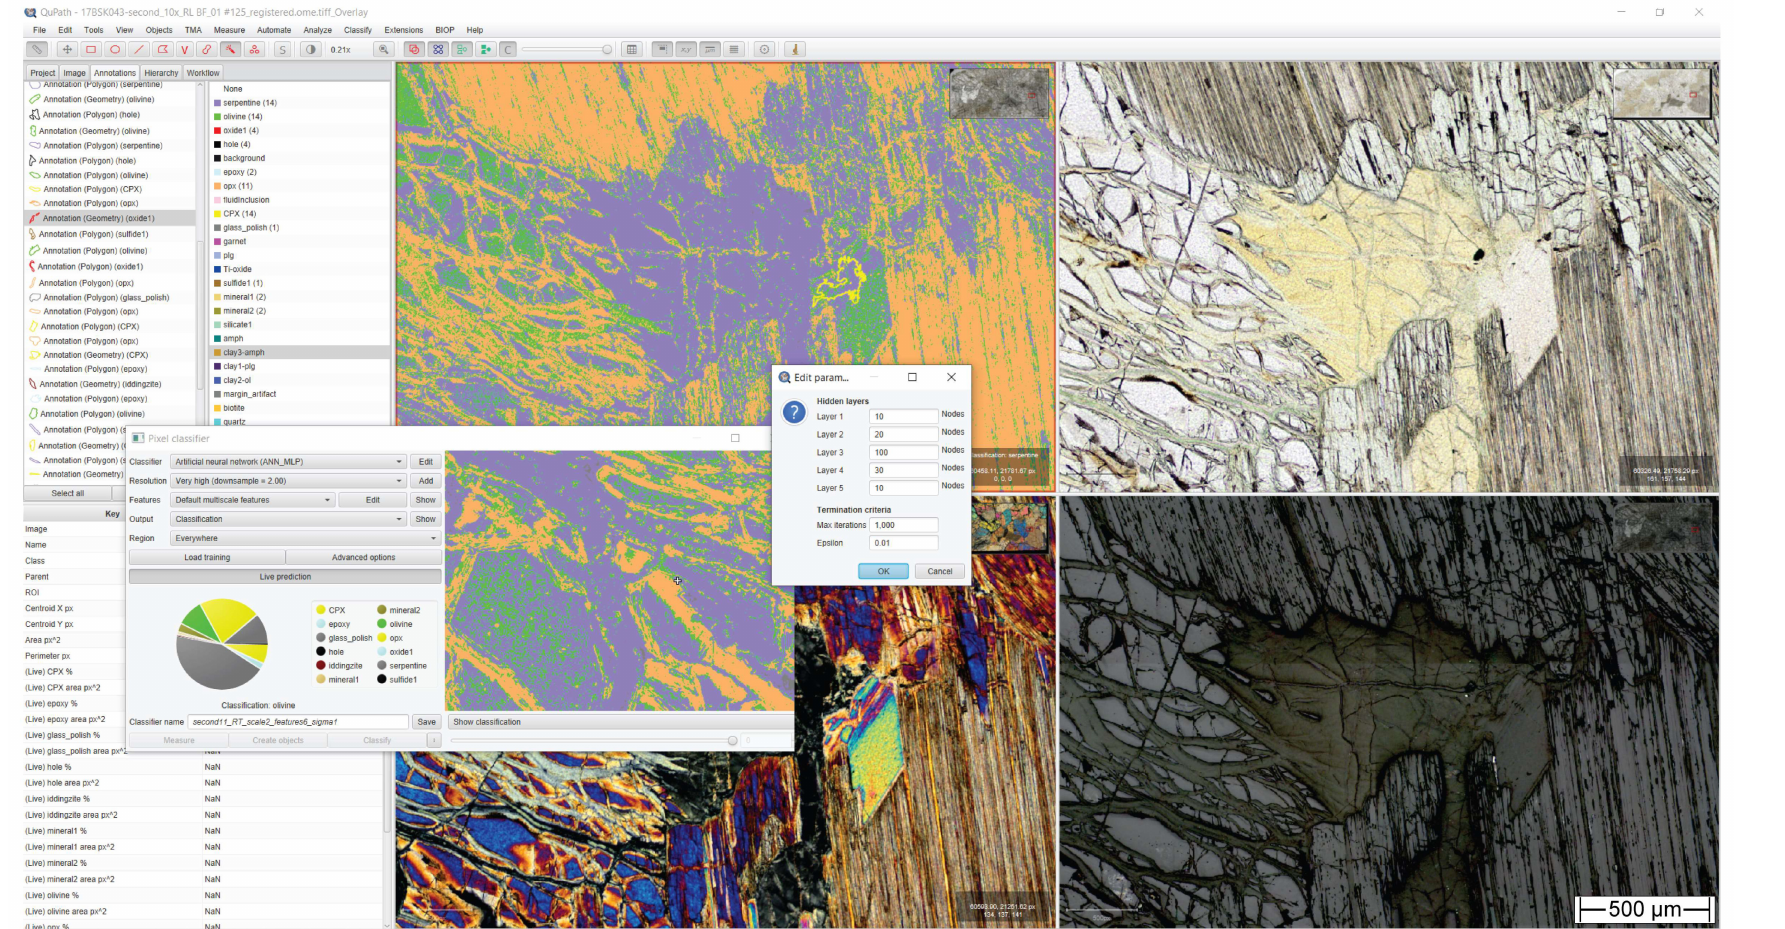
Figure 7. QuPath platform using a multi-view canvas (2 × 2) with the ray tracing image stack overlaid by ‘live’ segmentation ( top-left ). The views show PPL-max ( top-right ), XPL-max ( bottom-left ), and RL γ -boosted (bottom-right) to give a petrographer views across all relevant modalities. The ‘Pixel classifier’ is operated to improve the labelled annotation set and to define classes for parametrised supervised clustering (centre sub-menu) following the mineral library ( top-left tab: ‘Annotations’). The graphical user interface (GUI) navigates and updates the segmentation on each pyramid block (see Figure 8) of the combined image while reading annotations, calculating feature maps, and enabling the saving of the WSI semantic segmentation